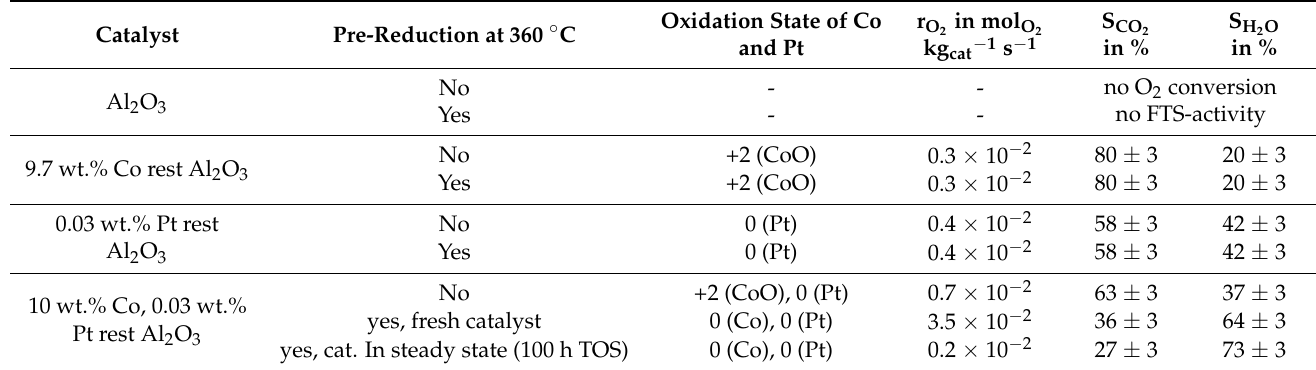
. V total = 7.5–75 L/h (NTP); p CO = 6 bar; p H = 2